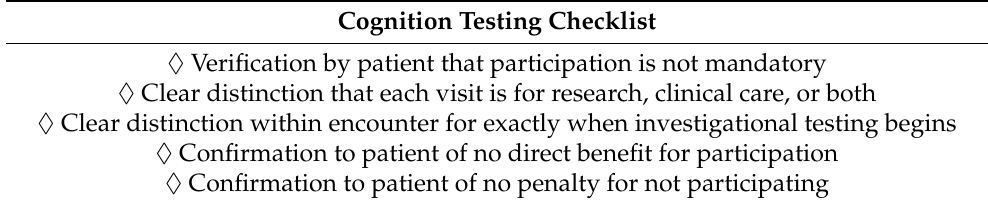
Table 1. Teach-Back Checklist for Cognition and Behavioral Testing. Cognition Testing